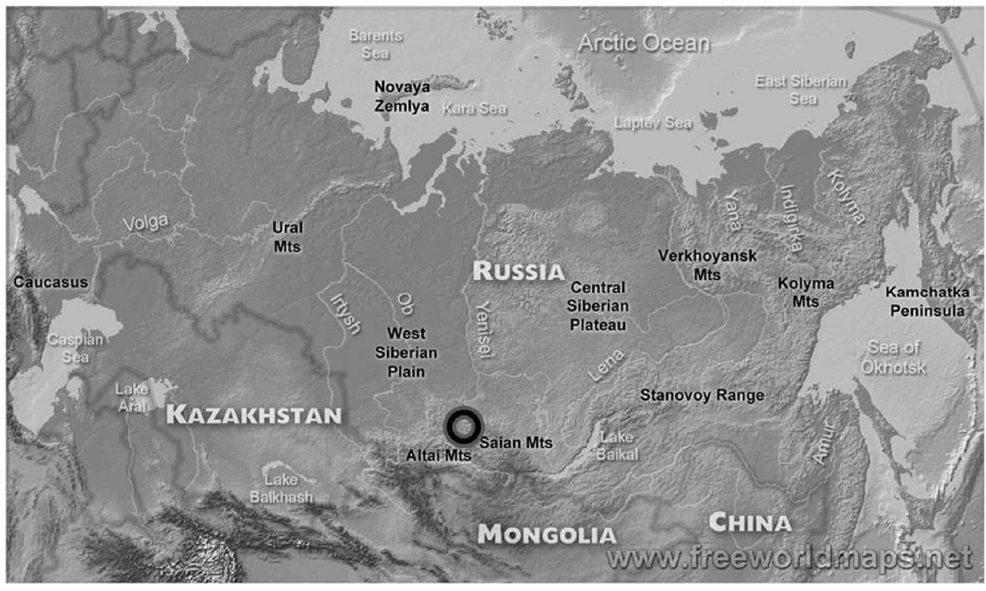
Figure 1. Study site location.